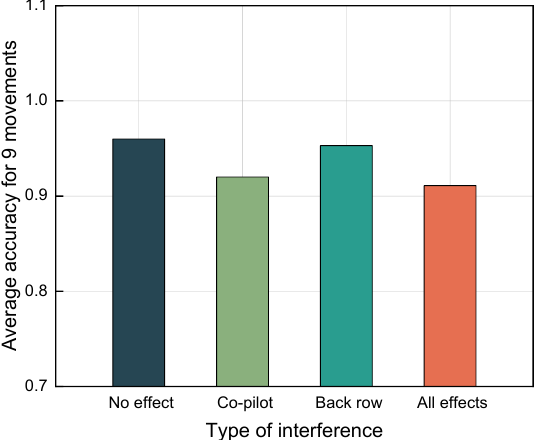
Figure 11. Histogram of the accuracy of unrelated target interference.